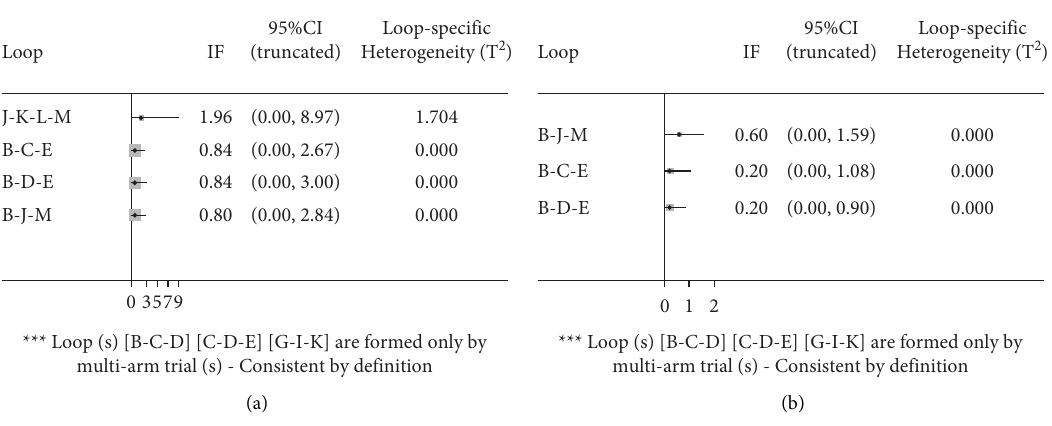
Figure 6: Inconsistency plot of this network meta-analysis. (a) Inconsistency plot of the daytime micturition frequency. (b) Inconsistency plot of the nocturia